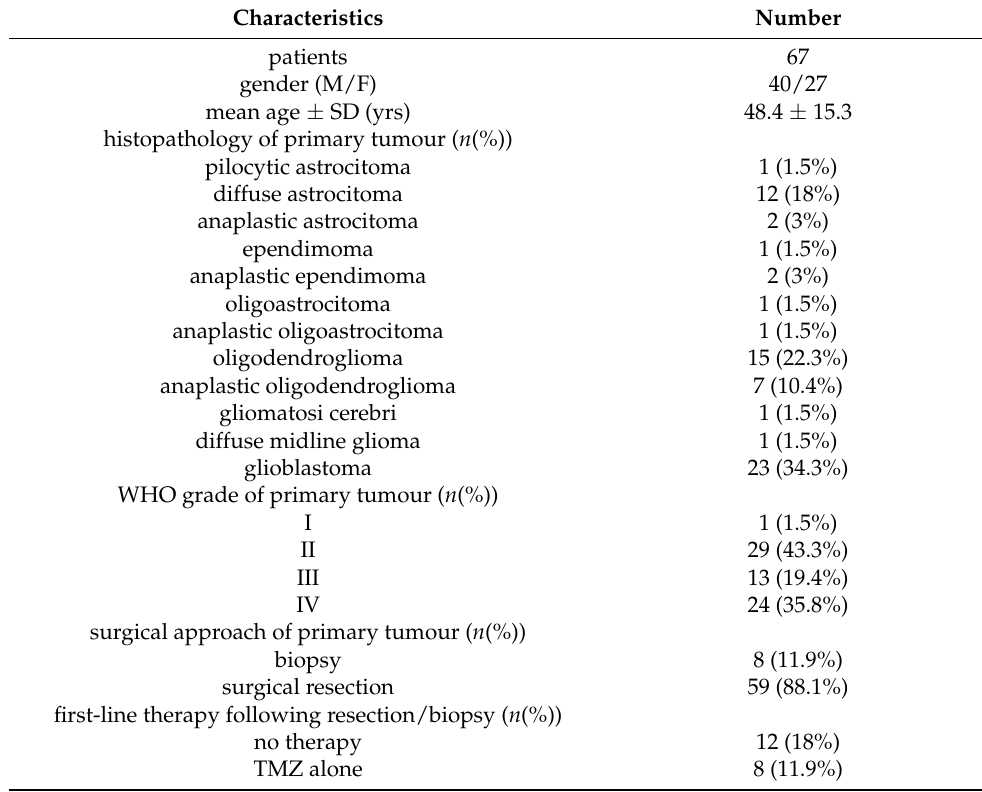
Table 1. Patient clinical characteristics in the overall population ( n =